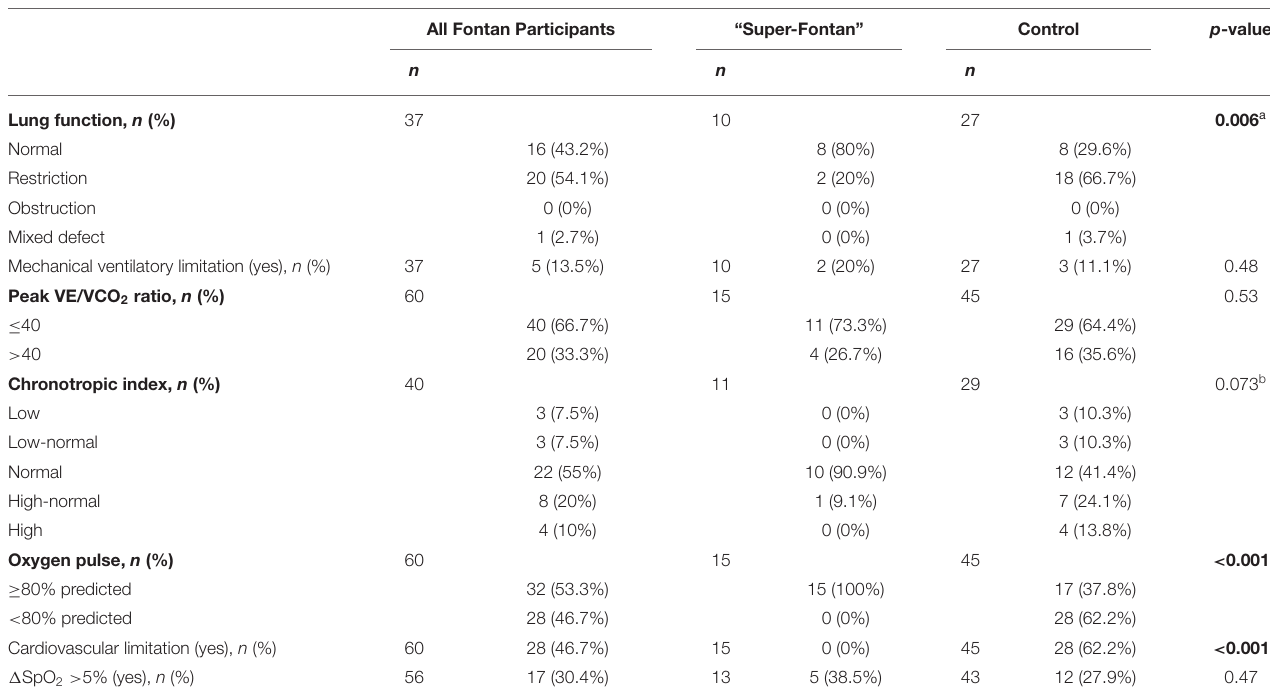
TABLE 3 | Lung function and cardiopulmonary exercise testing result